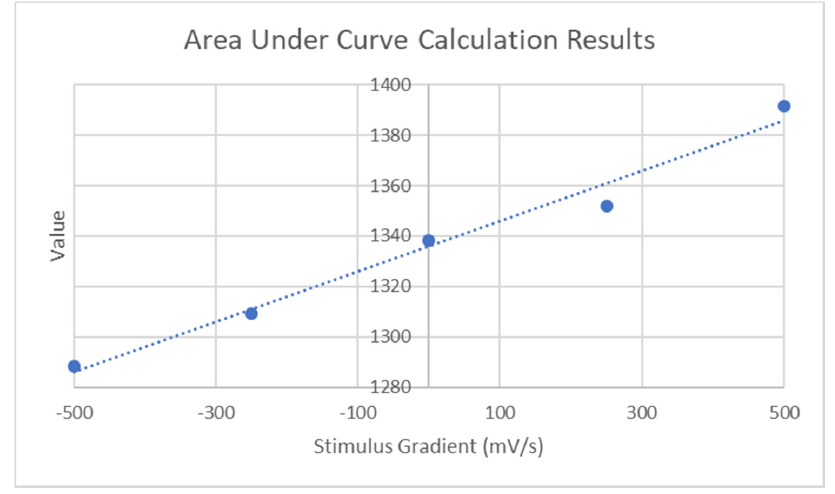
Figure 12. Relationship between ramp rate and area under curve.